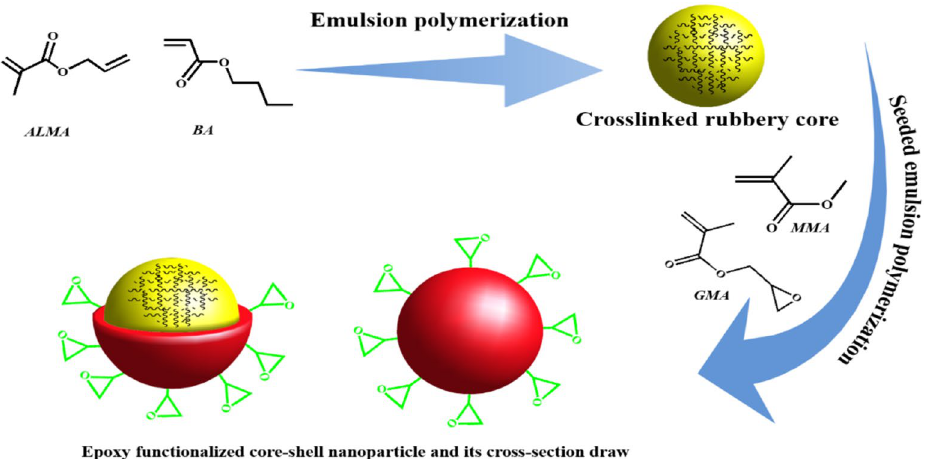
Figure 1. Schematic illustration of preparation steps of